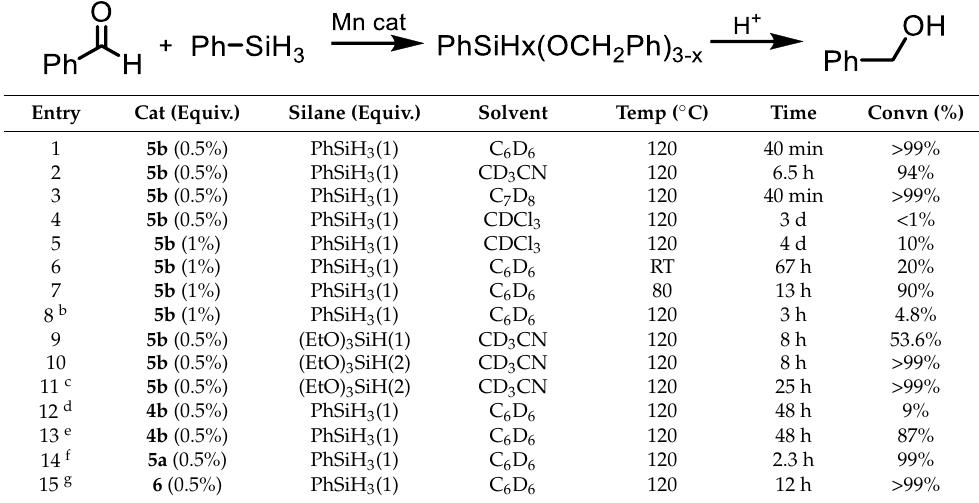
Table 1. Hydrosilylation of PhCHO under different conditions a .